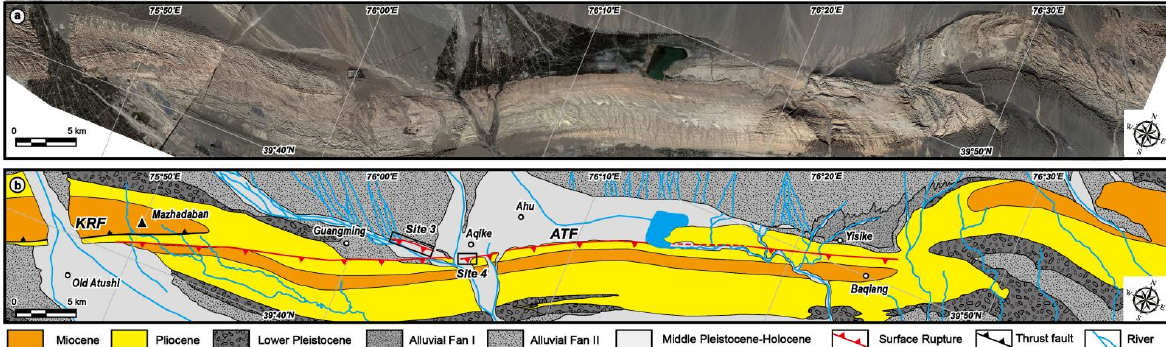
Figure 3. Geometric feature of surface rupture zones along the ATF. ( a ) GF-2 satellite image after fusion of multi-spectral and panchromatic images; ( b ) geological interpretation of GF-2 satellite image showing the geometric features of the surface rupture zone developed along the ATF.